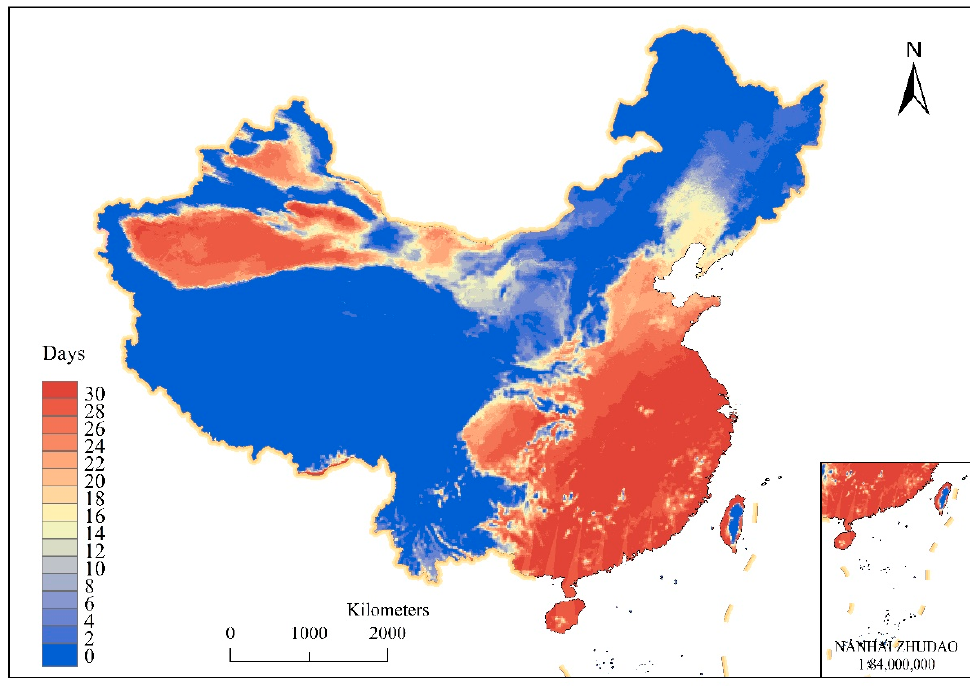
Figure 7. The duration of heat stress in China in August 2020.